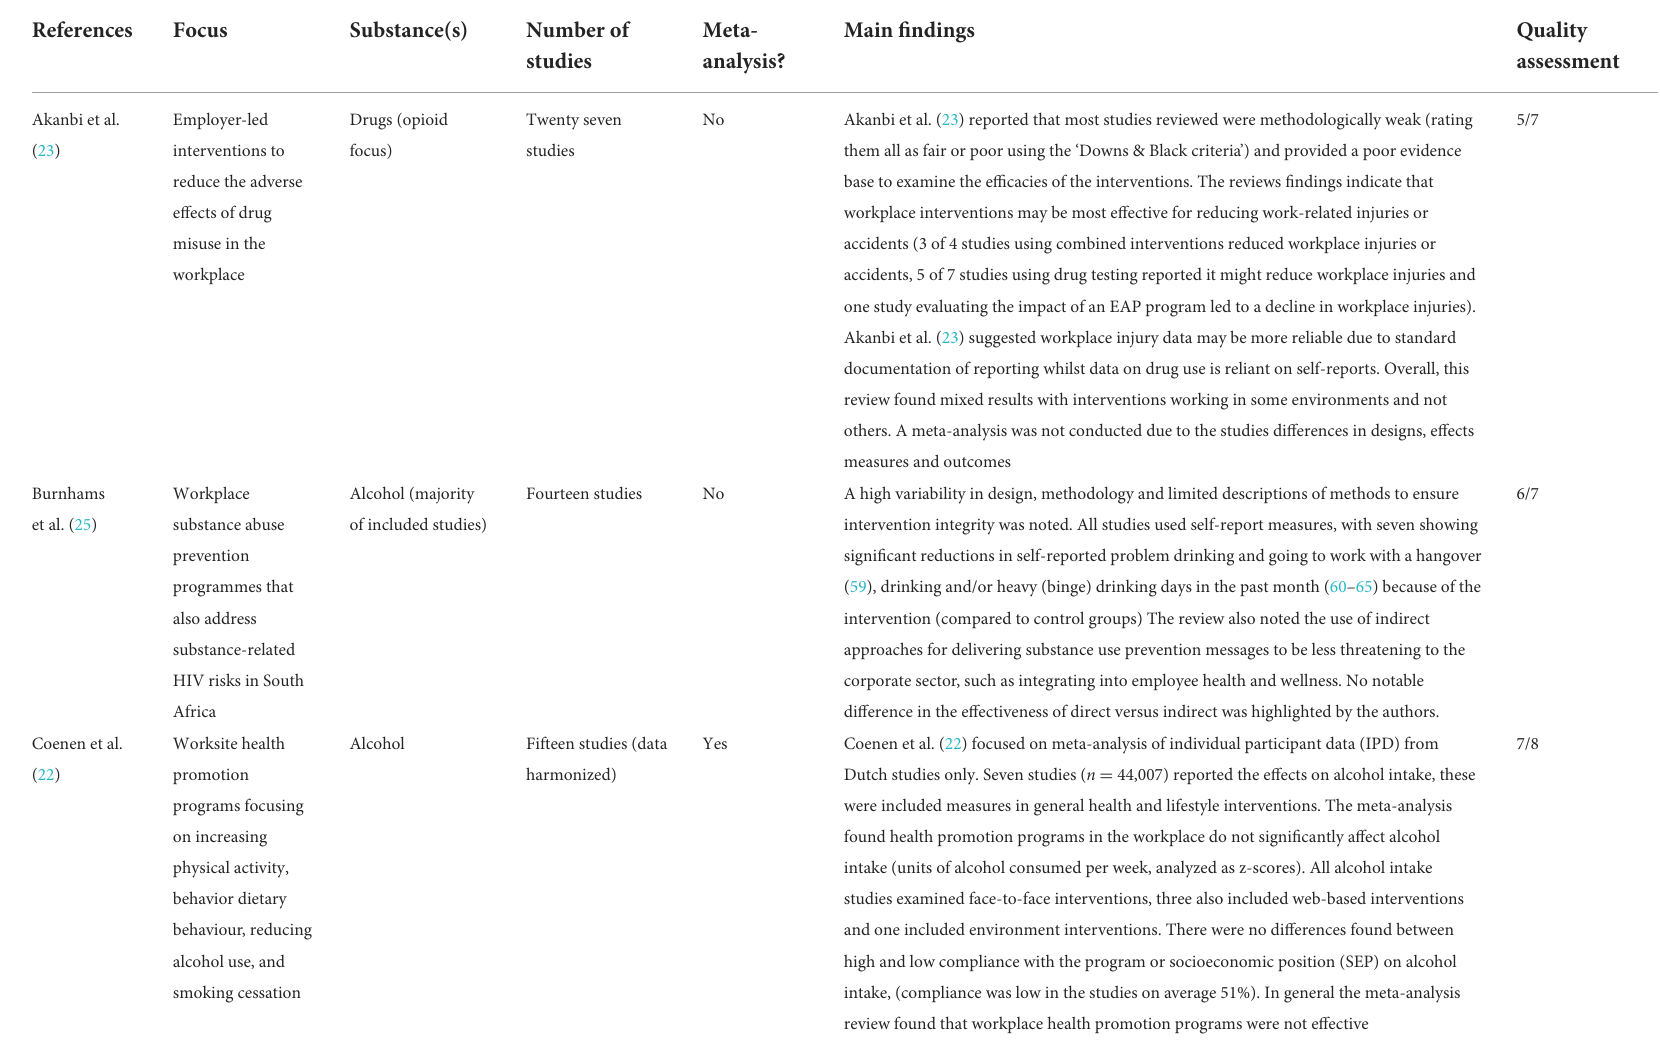
TABLE 2 Characteristics of reviews evaluating the effectiveness workplace-based interventions for the prevention and treatment of problematic substance